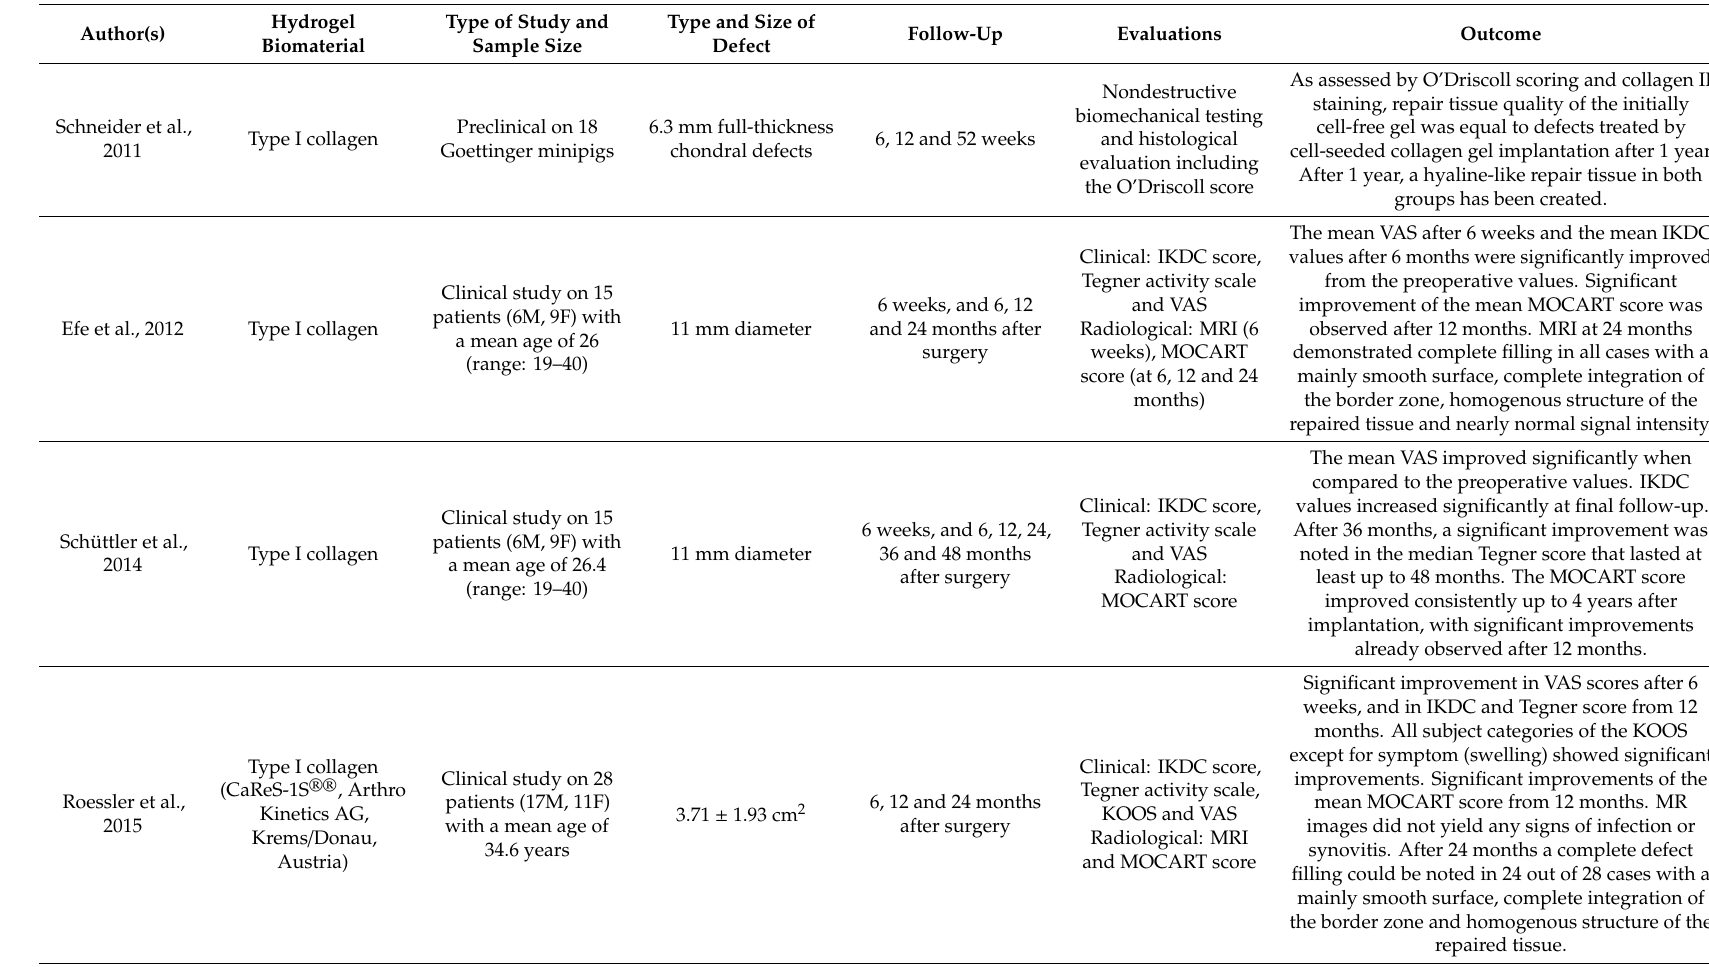
Table 1. Overview of studies testing cell-free hydrogel sca ff